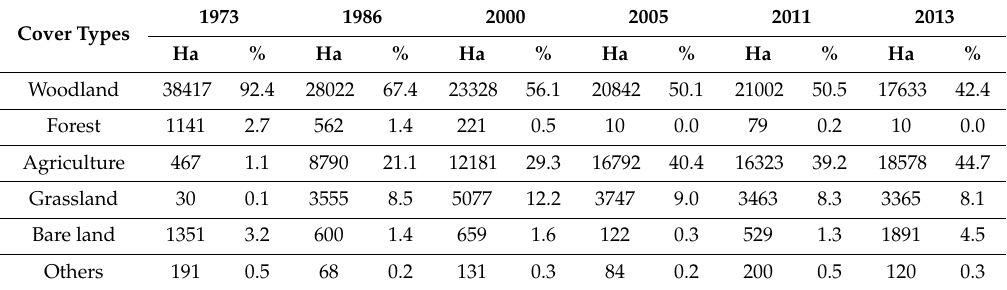
Table 5. Land cover change in hectare and percentages of the change for each land cover class between the periods indicated.